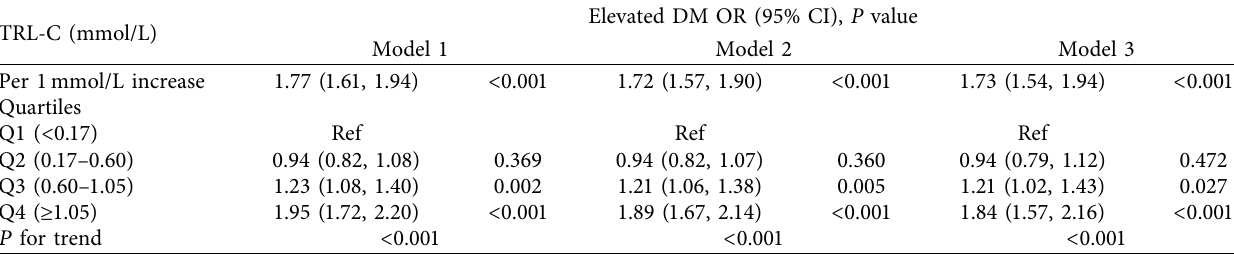
Table 3: Multivariate logistic regression models for prevalence of DM in hypertensive patients.